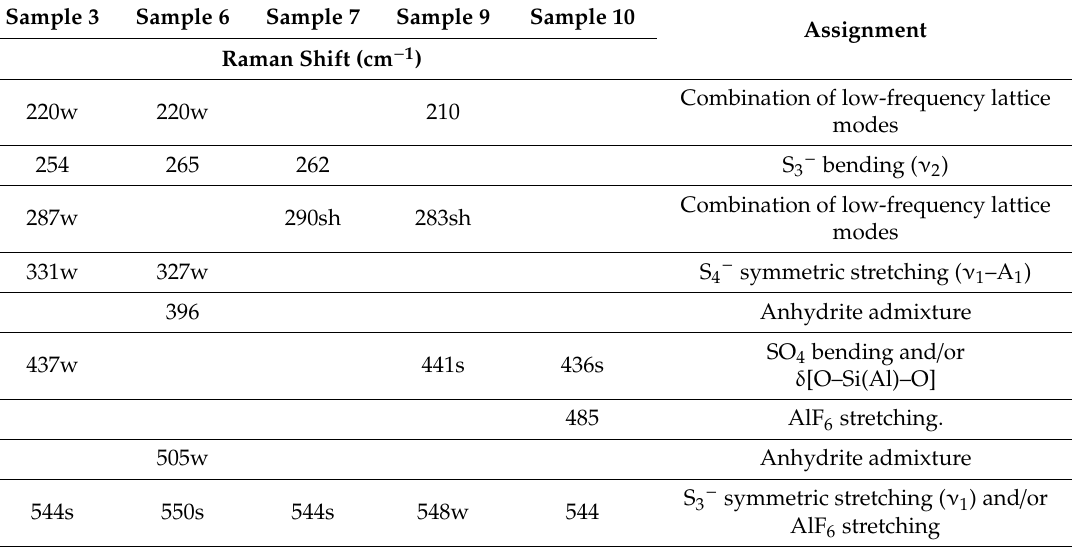
Table 5. Atom coordinates, equivalent displacement parameters (in Å 2 ), site occupancy factors (s.o.f.) and site multiplicities ( Q ) for the Sample 9.